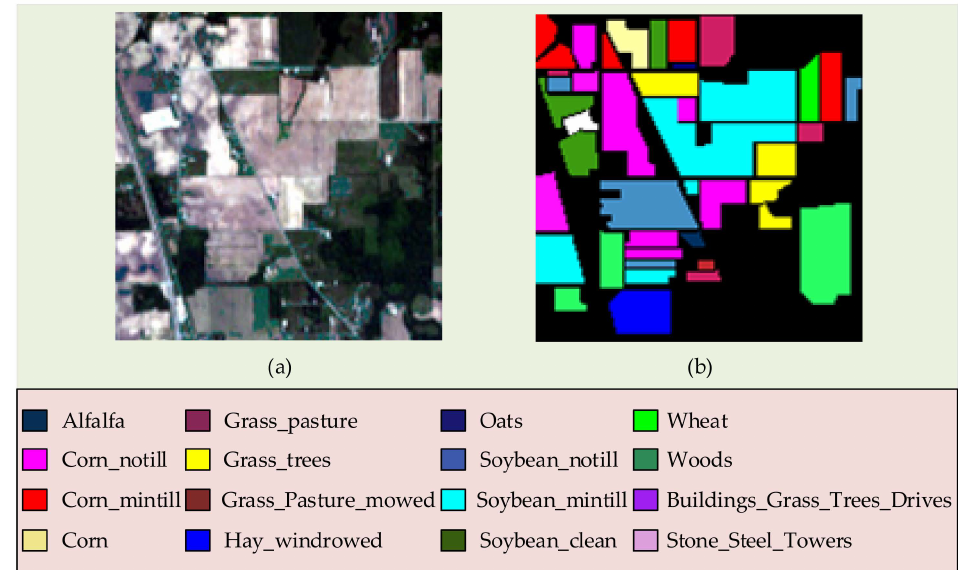
Figure 1. ( a ) original Indian Pines image; ( b ) ground reference map of Indian Pines.